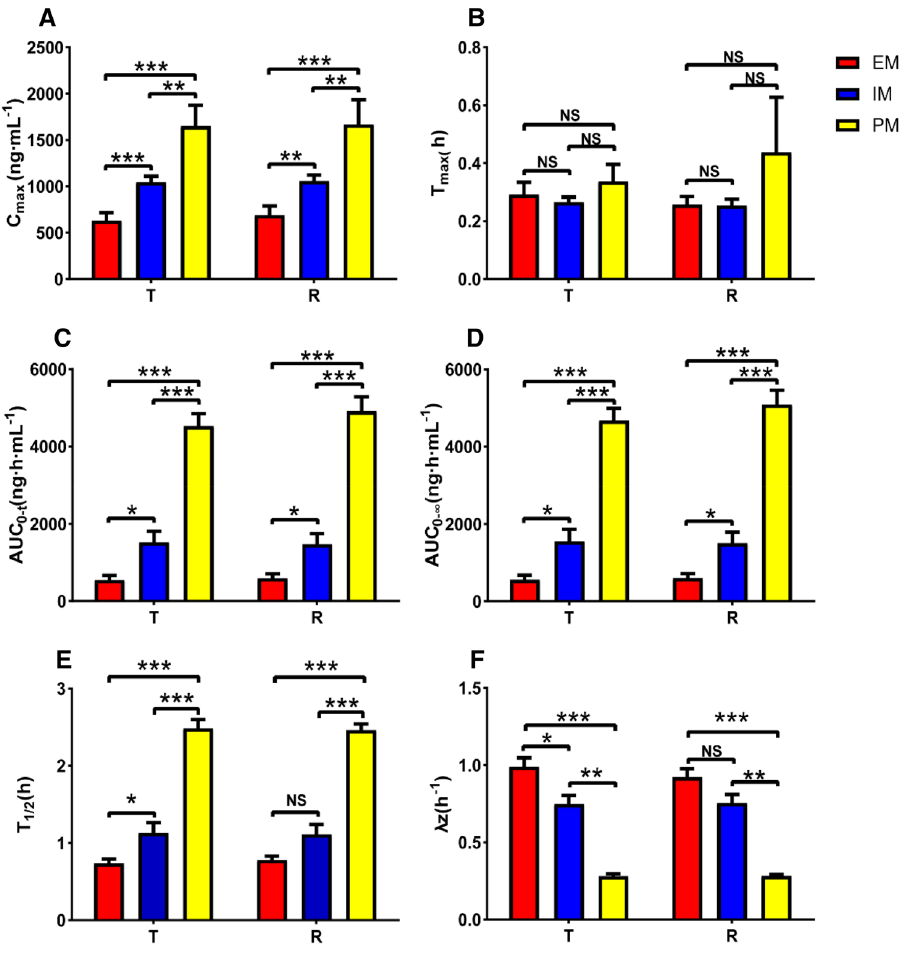
Figure 4. Comparison of omeprazole C max ( A ), T max ( B ), AUC 0–t ( C ), AUC 0–∞ ( D ), T 1/2 ( E ) and λz ( F ) between different CYP2C19 genotypes after oral administration of test preparation and reference preparation. p >